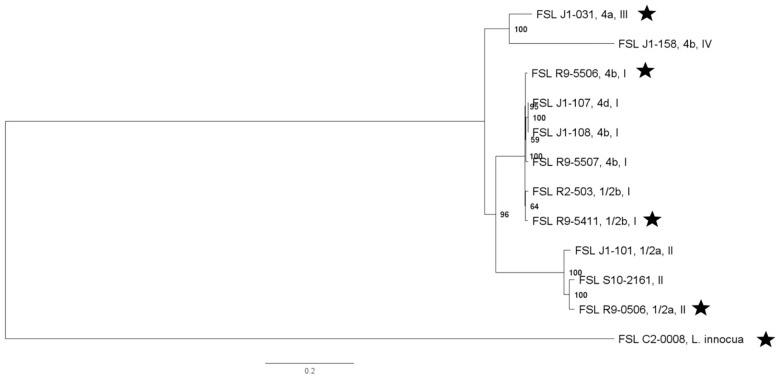
Listeria maximum-likelihood tree based on core SNP analysis using kSNP. The phylogeny for strains was inferred using RAxML and tree was rooted by midpoint. The strain FSL ID is followed by serotype and lineage. The node labels represent bootstrap values of 1000 repetitions. The bar indicates 0.2 substitutions per site. Strains marked with a star were selected as representative strains for phenotypic analyses (i.e., PAA experiments).